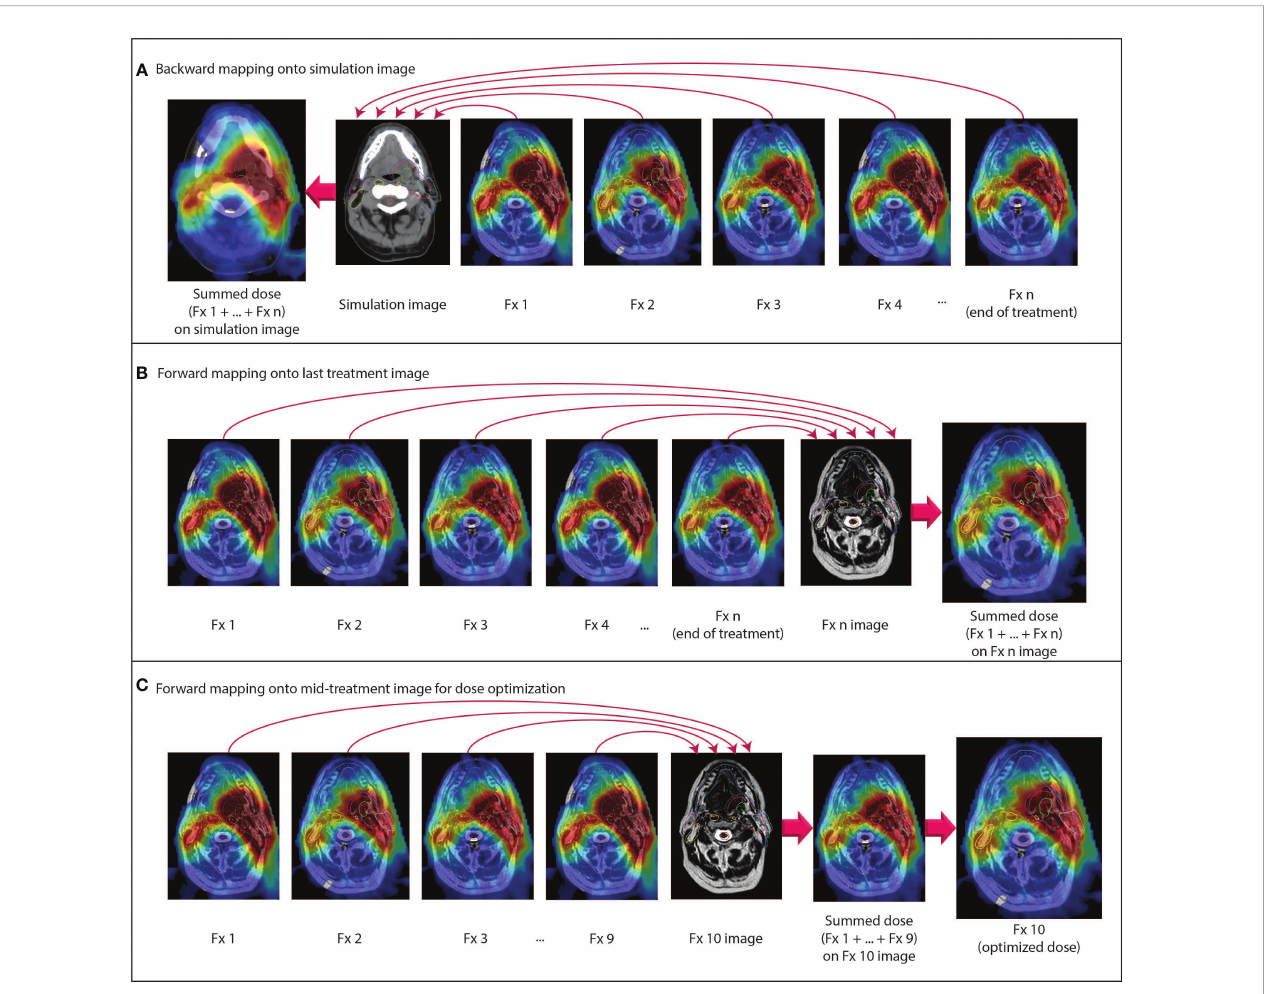
FIGURE 2 Examples of different dose accumulation perspectives. (A) Doses from all fractions are mapped backward onto the pre-treatment simulation anatomy. (B) Doses from all fractions are mapped forward onto the anatomy from the last fraction. (C) At a given time point during RT, all previous doses are mapped forward onto the anatomy for the current fraction. The summed dose is used as an input for dose-optimized adaptive replanning. All doses are scaled to the total prescription